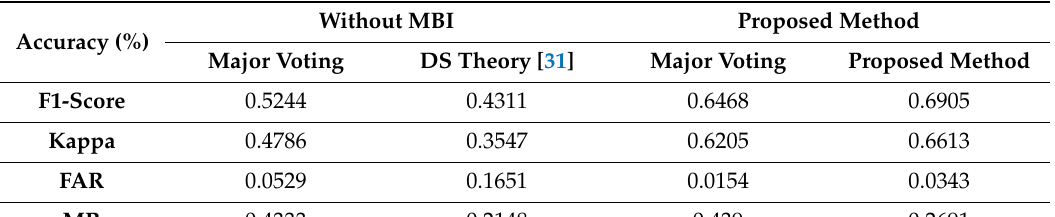
Table 4. Accuracy assessment of change detection for second subset results generated without using MBI and by the proposed method.